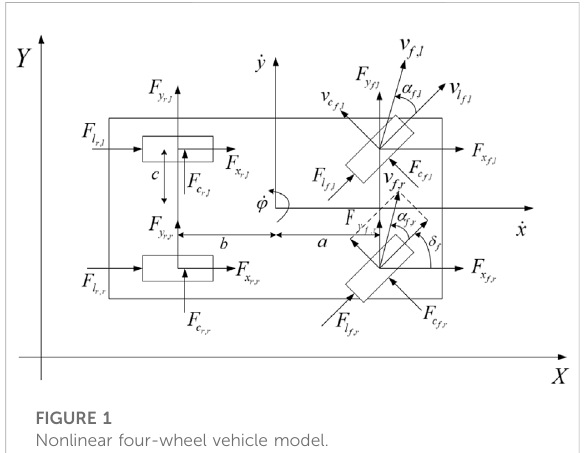
FIGURE 1 Nonlinear four-wheel vehicle